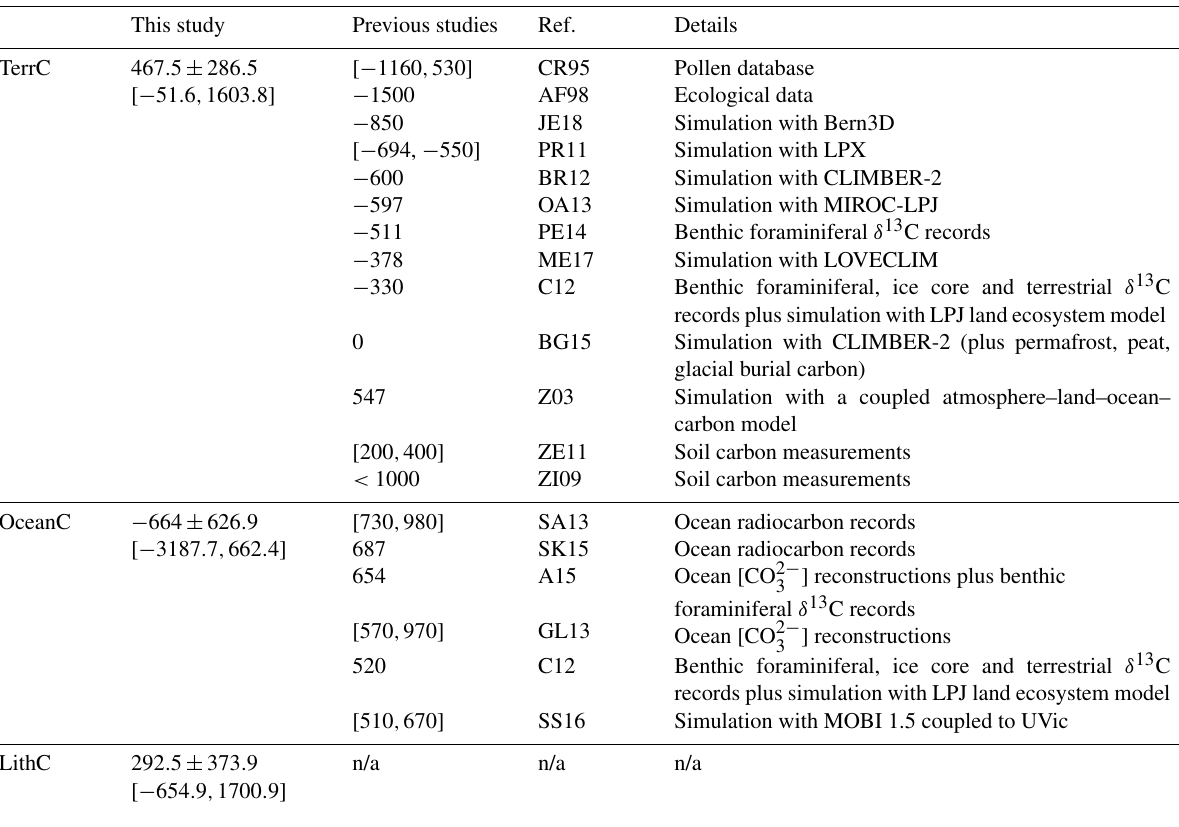
Table 4. LGM-PI difference in terrestrial ( (cid:49) TerrC), ocean ( (cid:49) OceanC) and lithospheric ( (cid:49) LithC) carbon inventory (PgC) in this study (ENS 104 mean, standard deviation and range) and previous studies. CR95 is Crowley (1995), AF98 is Adams and Faure (1998), Z03 is Zeng (2003), ZI09 is Zimov et al. (2009), PR11 is Prentice et al. (2011), ZE11 is Zech et al. (2011), BR12 is Brovkin et al. (2012), CI12 is Ciais et al. (2012), GL13 is Goodwin and Lauderdale (2013), OA13 is O’ishi and Abe-Ouchi (2013), SA is Sarnthein et al. (2013), PE14 is Peterson et al. (2014), AL15 is Allen et al. (2015), BG15 is Brovkin and Ganopolski (2015), SK15 is Skinner et al. (2015), SS16 is Schmittner and Somes (2016), ME17 is Menviel et al. (2017) and JE18 is Jeltsch-Thömmes et al. (2019). This study Previous studies Ref.